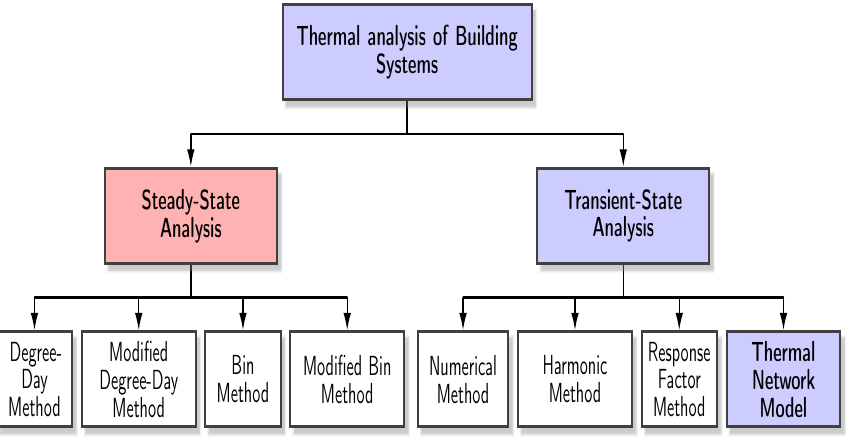
Figure 4. Building thermal modeling